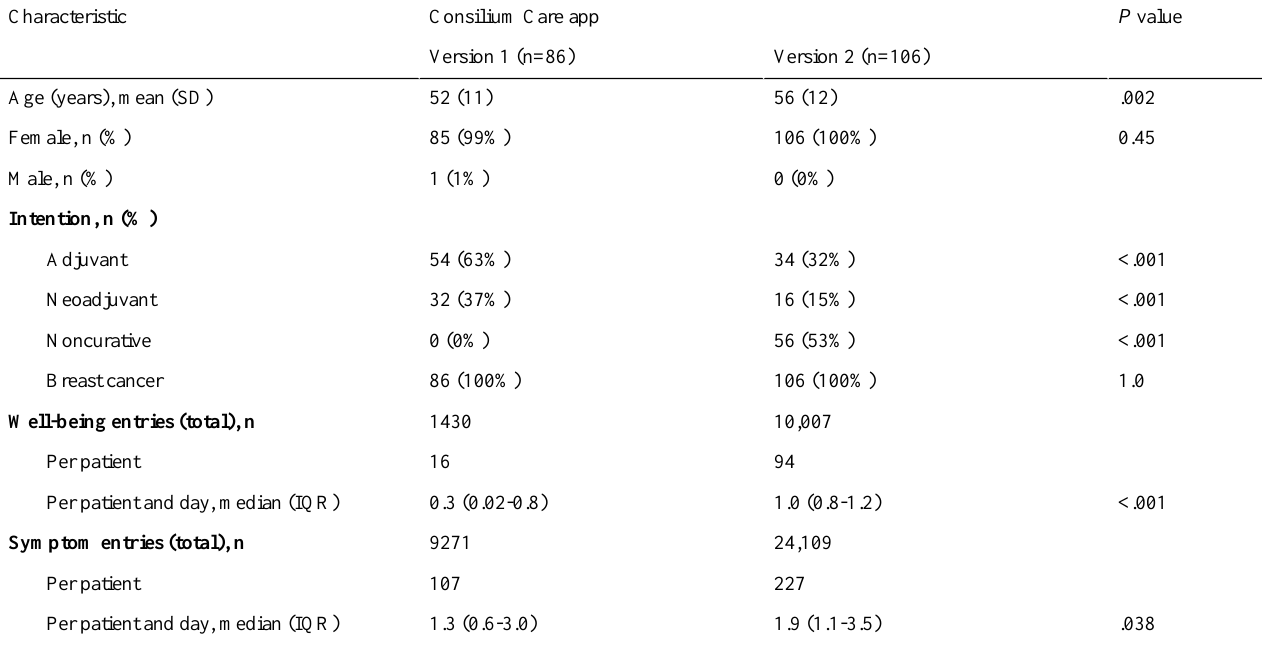
Table 1. Patient